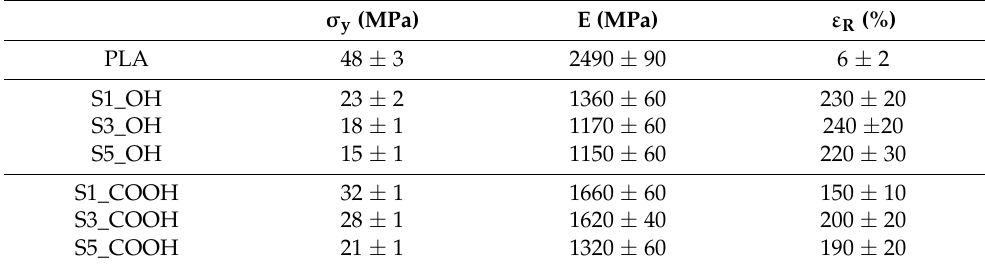
Table 3. Stress-at-yield ( σ y ), elastic modulus (E), and strain-at-break ( ε R ) calculated from tensile test. σ y